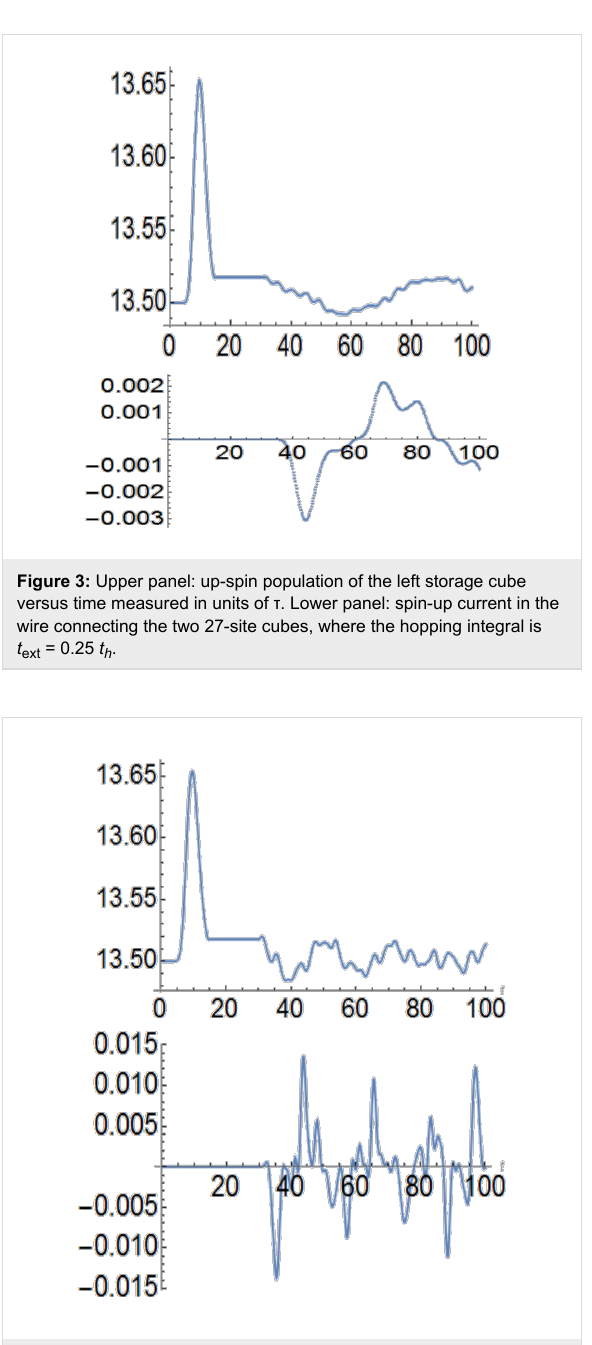
Figure 4: Upper panel: up-spin population on the left storage cube versus time measured in units of τ . Lower panel: spin-up current in the wire connecting the two 27-site cubes, where the hopping integral is t ext = 0.75 t h